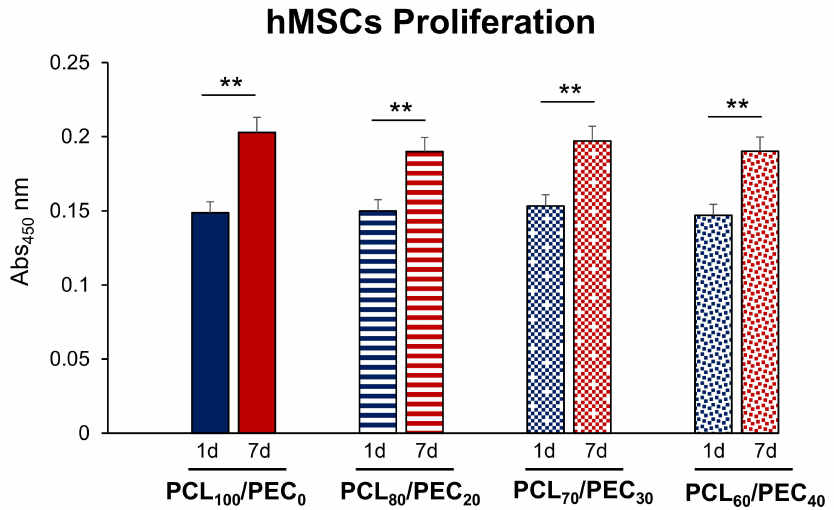
Figure 9. Cell proliferation (abs 450 nm) of the human mesenchymal cells (hMSCs) cultured on PCL/PEC films during days 1 and 7. ** p < 0.01, 1 vs. 7 days of